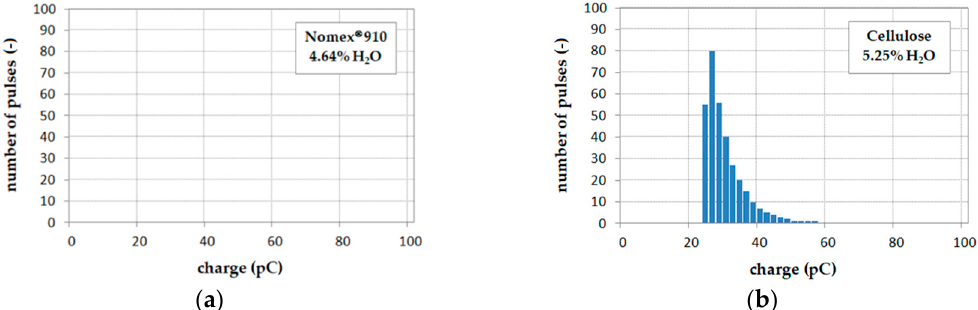
Figure 8. Frequency-amplitude distribution of partial discharges in aramid-enhanced cellulose paper ( a ) and cellulose paper ( b ), conditioned in the same conditions (the highest moisture in paper); U = 7.9 kV.